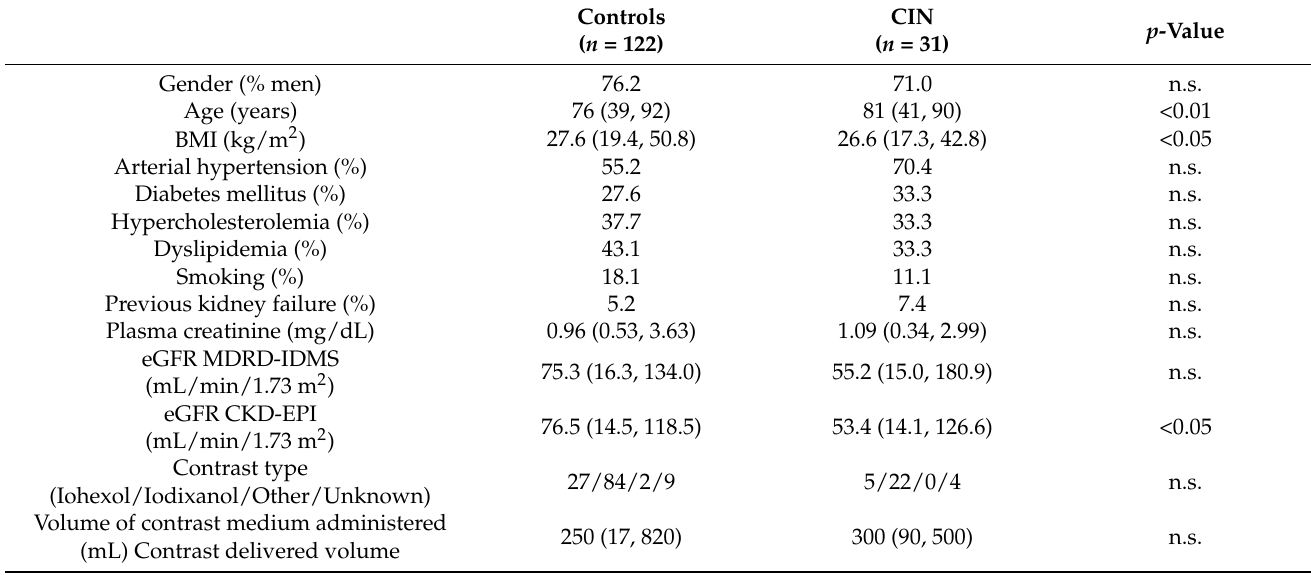
Table 1. Table describes the baseline characteristics of the patients (CIN group, n = 31) with an increase of plasma creatinine of greater than or equal to 0.5 mg/dL (or an increase of 25% from baseline) and those of those who did not meet those criteria (Controls group, n = 122). Descriptive data and risk factors of the patients included in the study. Data are presented as percentage or median (minimum, maximum). Previous kidney failure: patients with plasma creatinine levels greater than 1.2 mg/dL (in men) or 0.9 mg/dL (in women) before contrast media administration. BMI: body mass index; CIN: contrast-induced nephropathy; CKD-EPI: Chronic Kidney Disease Epidemiology Collaboration; eGFR: estimated glomerular filtration rate; MDRD-IDMS: Modification of Diet in Renal Disease-Isotope Dilution Mass Spectrometry; n.s. not